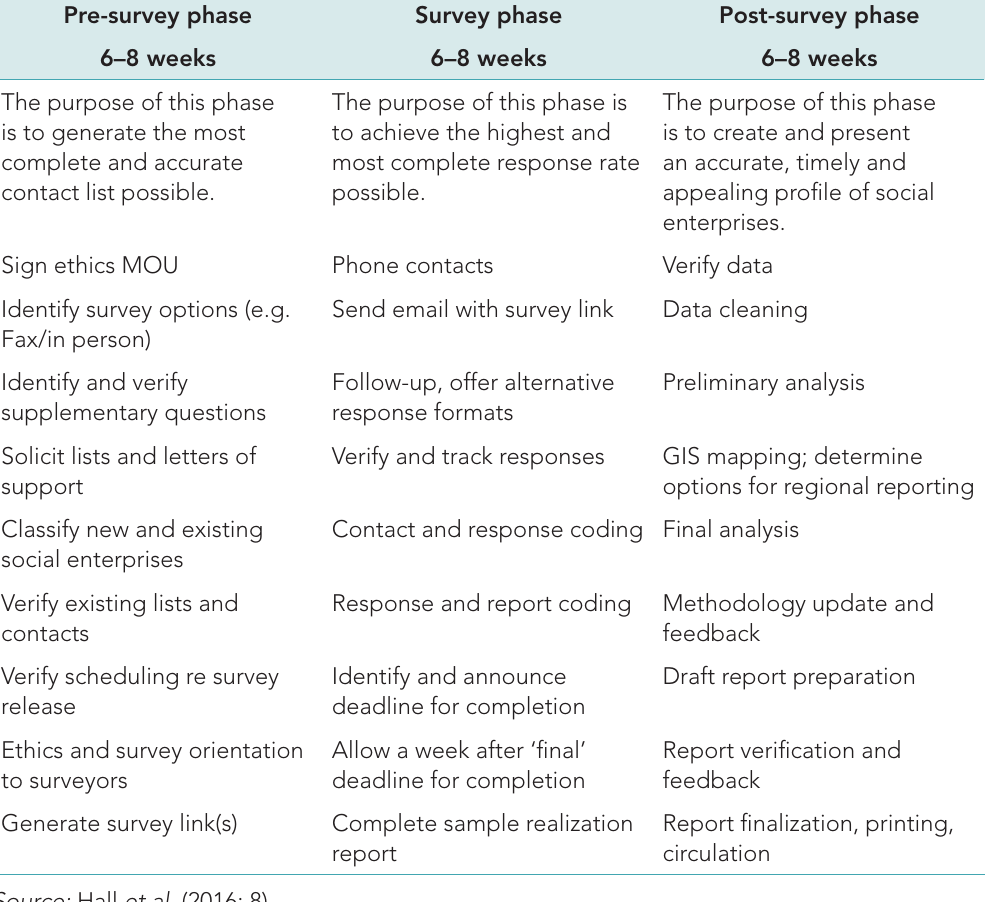
Table 1: SESS survey workflow Pre-survey